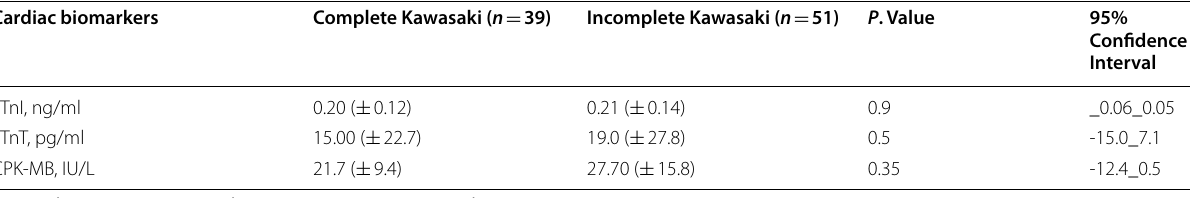
Table 3 Comparison of cTnI, cTnT and CPK‑MB as cardiac biomarkers of subclinical myocarditis in complete vs. incomplete Kawasaki